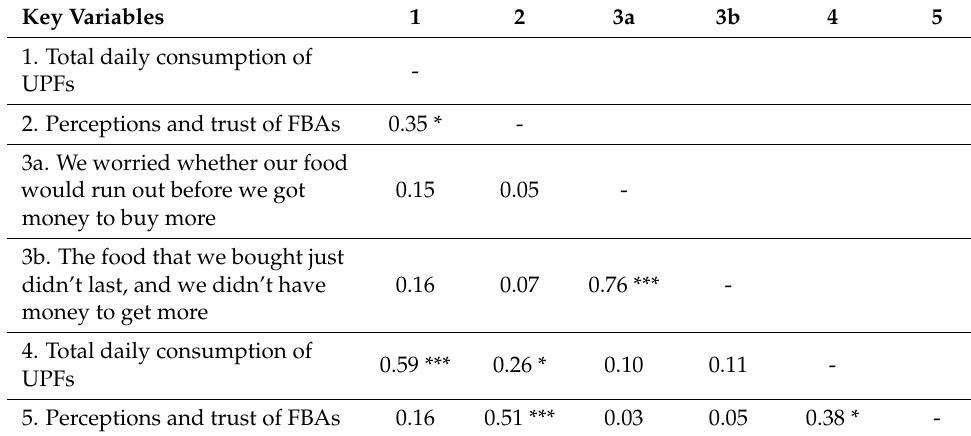
Table 3. Pairwise correlation matrix of variables of